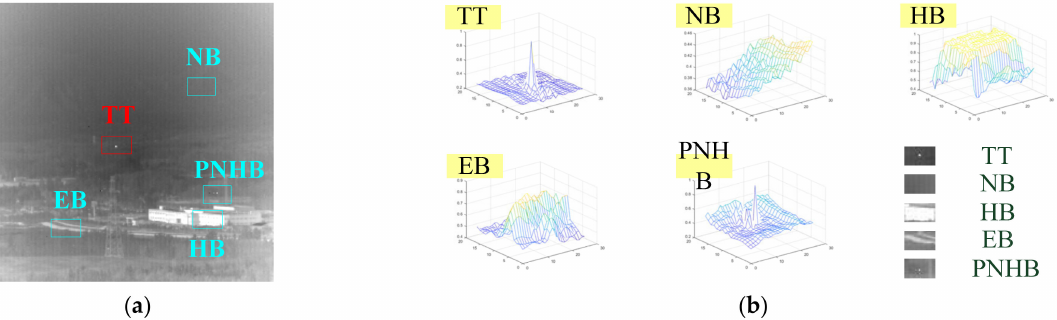
Figure 1. ( a ) Infrared small target image; ( b ) 3D maps of various local components of an infrared